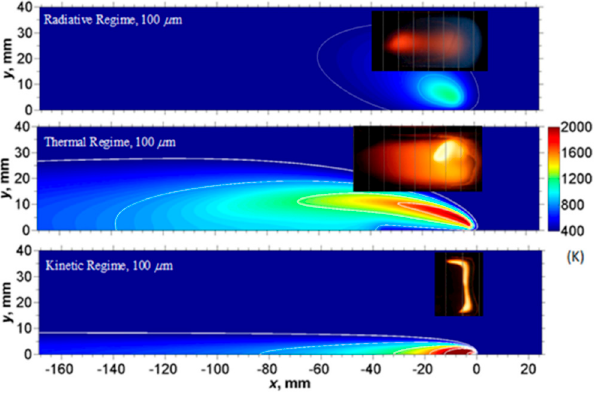
Figure 20. Computational flame shapes and experimental flame shapes [161]. Figure 24. Computational flame shapes and experimental flame shapes [161].